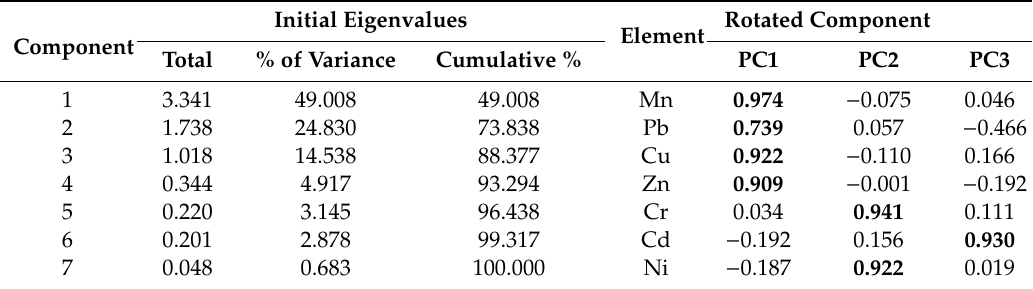
Table 4. Total variance and principal component analysis (PCA) of PTEs concentrations in the soil. Strong contribution of components to variability in individual PCs highlighted in bold